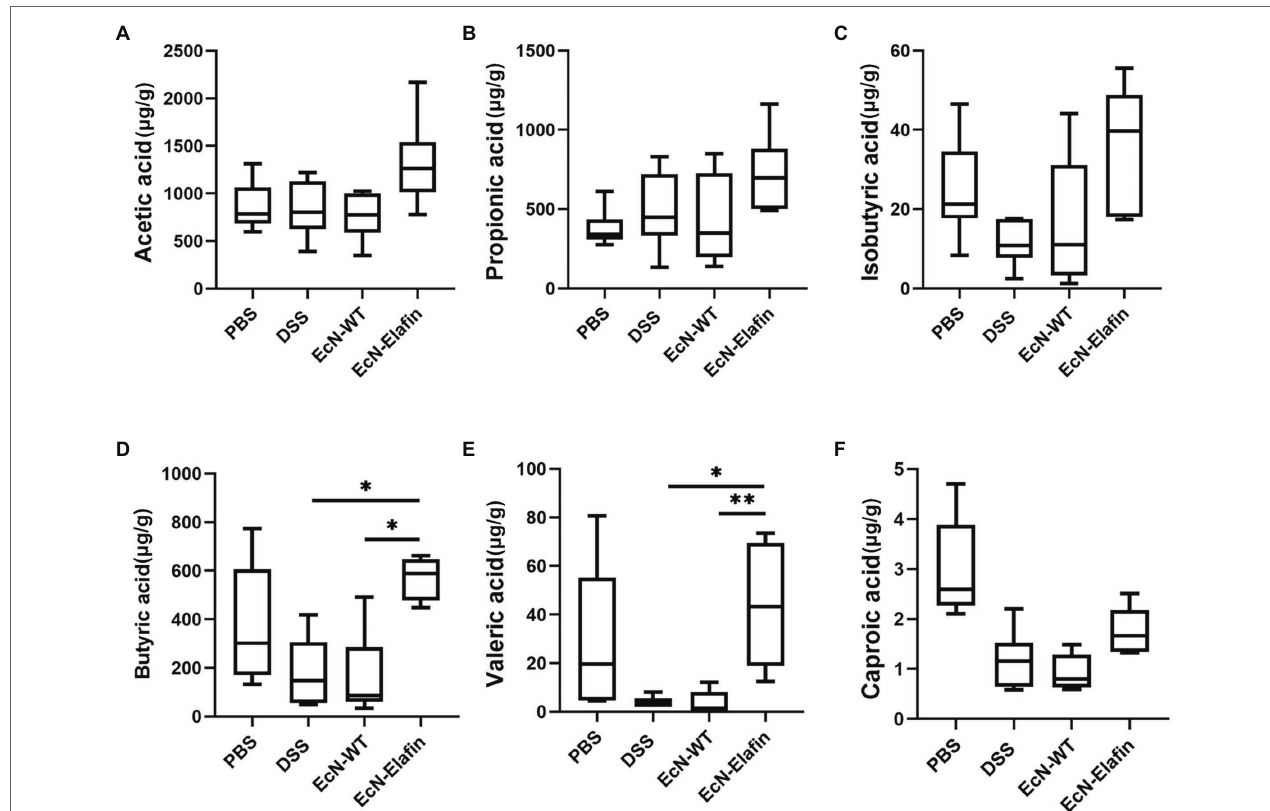
FIGURE 6 | EcN-Elafin increased the levels of SCFAs in the gut of DSS challenged mice. Levels of SCFAs in fecal samples, including (A) acetic acid, (B) propionic acid, (C) isobutyric acid, (D) butyric acid, (E) valeric acid, and (F) caproic acid in each mouse were determined. n = 6 in each group. * p < 0.05; ** p <